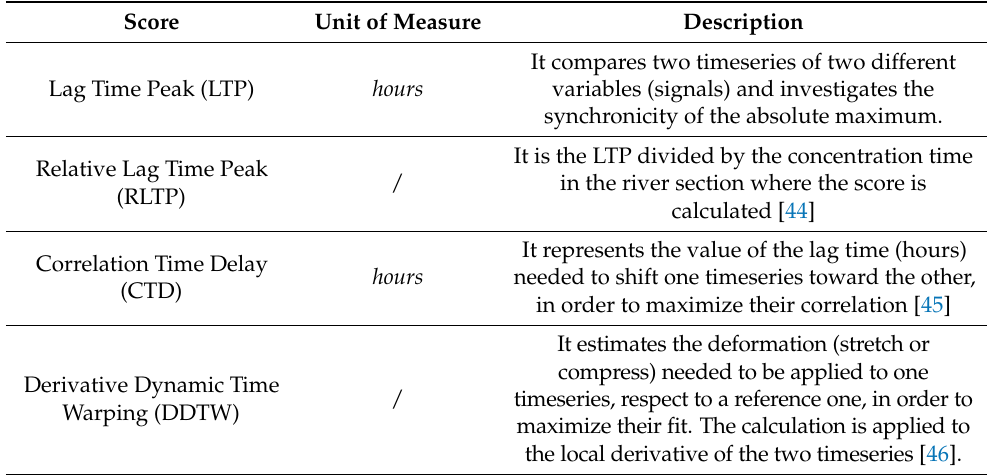
Table 3. Statistical scores used to evaluate the indices timing, compared to the hydrometric level temporal